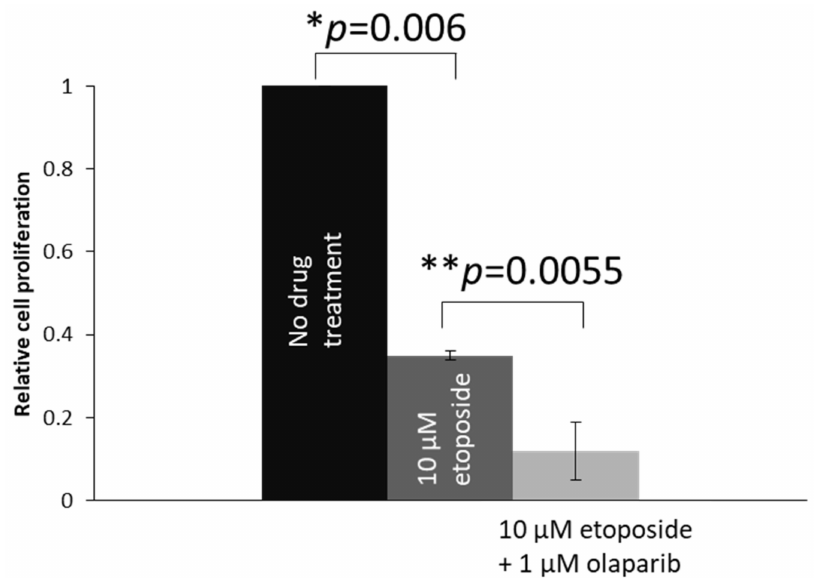
Figure 6. Cell proliferation analysis by using the EdU synthesis assay. Proliferation of the 1 µ M Olaparib- and 10 µ M etoposide-co-treated cells was significantly lower than the 10 µ M etoposide- treated cells. Experiments were repeated three times. Data are shown as mean ± standard deviation and analyzed using two-tailed unpaired t test. * and ** represent statistical significance of p = 0.006 and p = 0.0055,